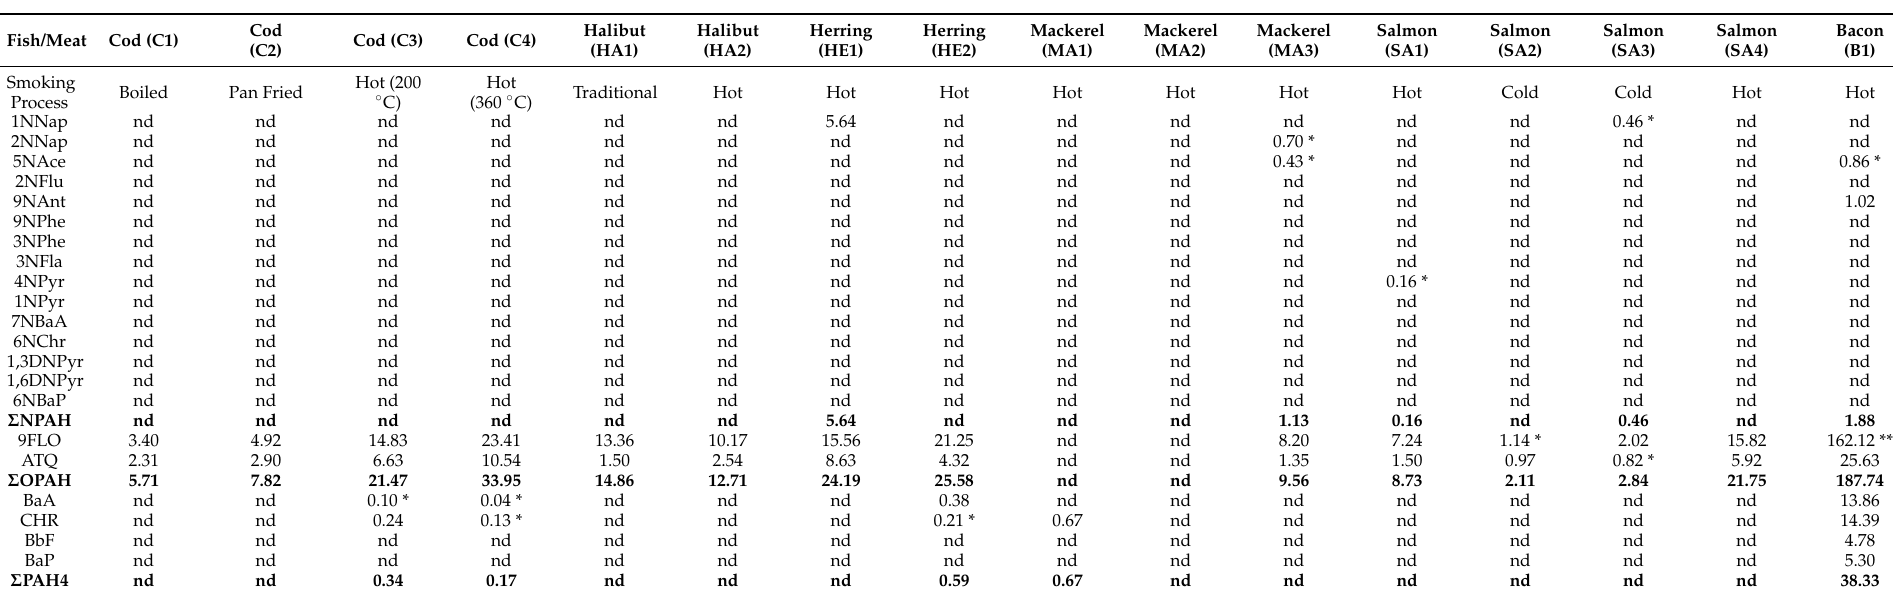
Table 3. Concentration of the polycyclic aromatic hydrocarbon (PAH), nitro-PAH (NPAHs), oxy-PAH (OPAHs) expressed as µ g/kg in 11 commercially smoked fish, one commercially smoked bacon (pork) sample, and four home cooked cod samples. The presented values are associated to the averaged method RSD R associated to each compound reported in Table S3 (total RSD R ). The values in bold are sum of nitrated PAHs ( Σ NPAH), oxygenated PAHs ( Σ OPAH) and PAH ( Σ